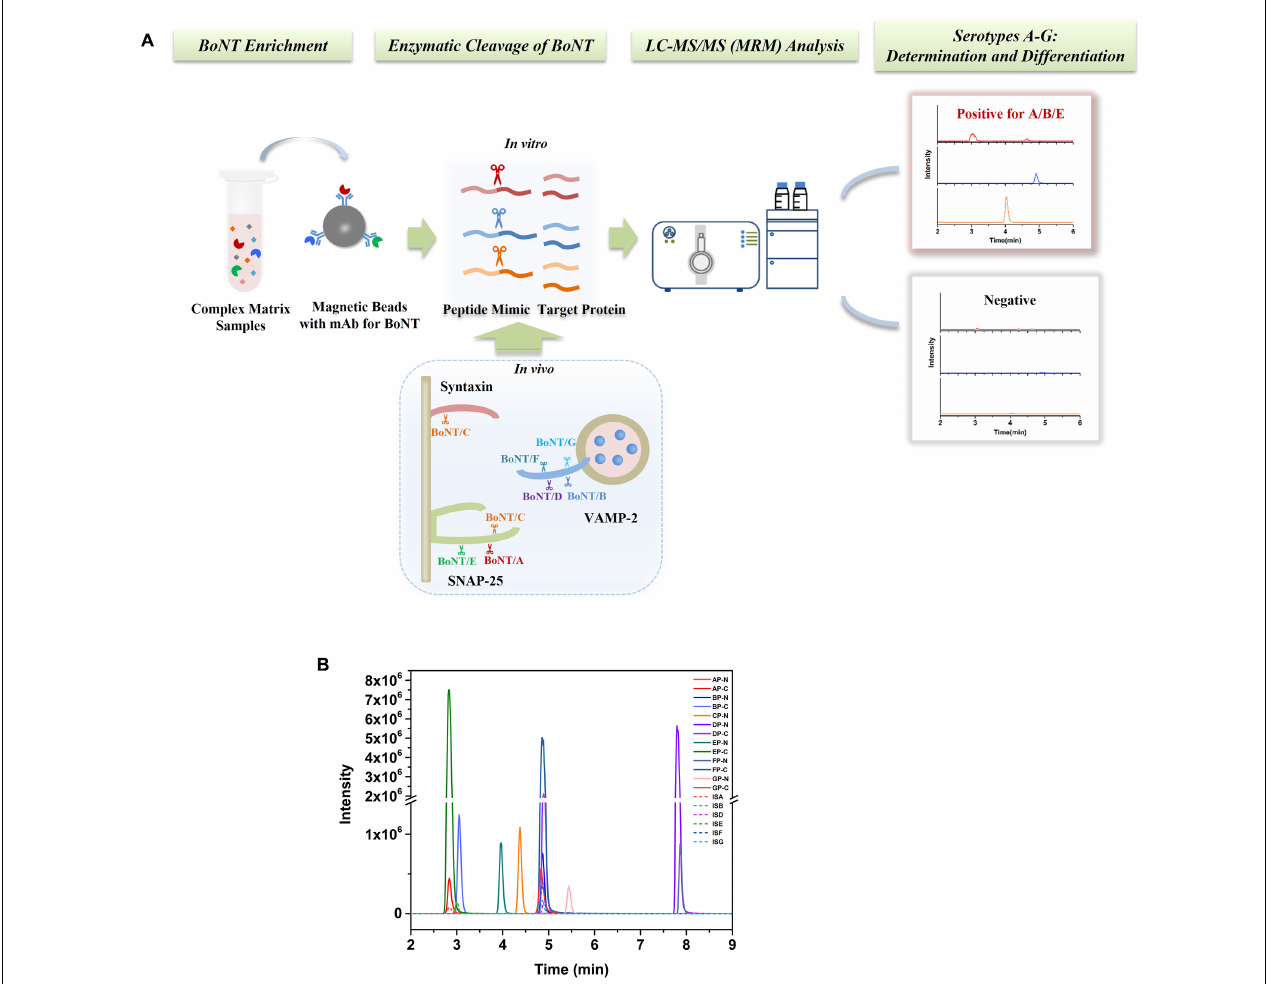
FIGURE 1 | (A) Schematic presentation of a stable isotope dilution Endopep-MS method for simultaneous detection of BoNTs A-G. (B) LC-MS/MS (MRM) peak intensities for N- and C-terminal cleavage products and their respective internal standard peptides of BoNTs A-G. Synthetic cleavage products of BoNTs A to G presented were at concentrations in the middle of their respective linear